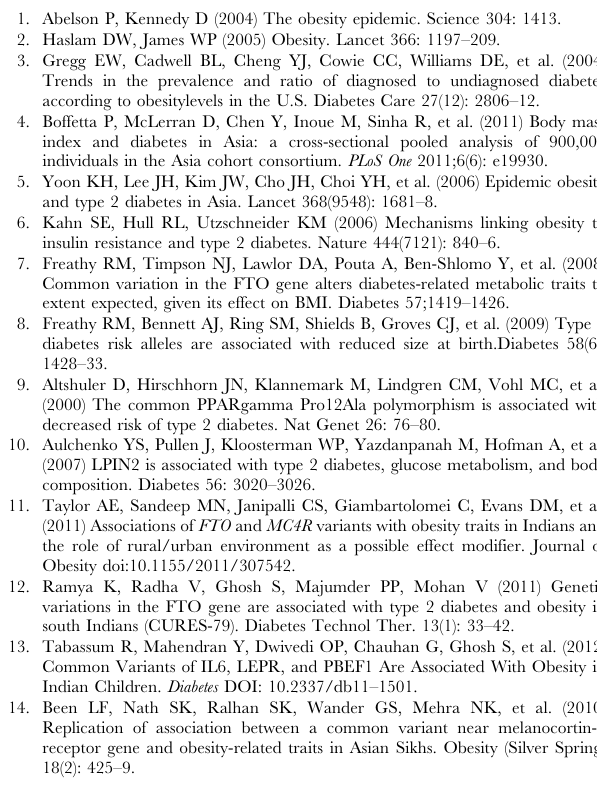
Table S1 Hardy-Weinberg equilibrium in Indian Migration Study (IMS). Table S2 Allele frequencies, effect sizes and evidence of association of 25 loci considered for analysis. Table S3 Power Calculations. Table S4 Within sib-pair association estimates for phenotypes related to obesity adjusted for daily energy and physical activity. Table S5 Within sib-pair association estimates for overweight. Table S6 Within sib pair effect of count and weighted risk score based on *8 significantly associated loci. Table S7 Sex specific within sib pair effects for significantly associated SNPs with